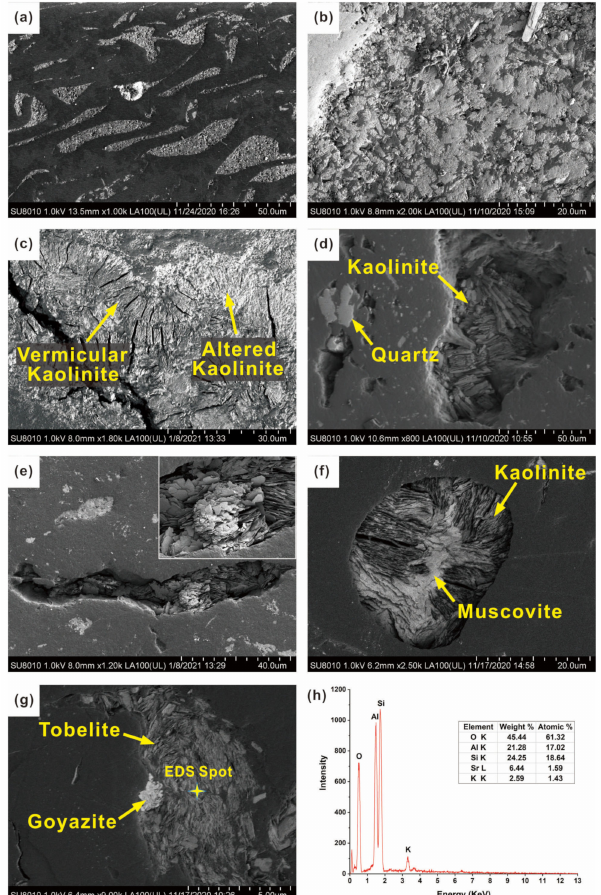
Figure 7. SEM backscattered electron images of kaolinite and other minerals in the Tashan coal: ( a ) cell-fill kaolinite in the unaltered coal; ( b ) kaolinite aggregates in the thermally altered coal; ( c ) vermicular kaolinite with its edge altered; ( d ) kaolinite aggregates in the cavity of maceral; ( e ) kaolinite aggregate filling in the crack; ( f ) book-like kaolinite intimately grown with muscovite; ( g ) cleat-fill tobelite with flake morphology; ( h ) the SEM-EDS spectra of tobelite in ( g ). 2.